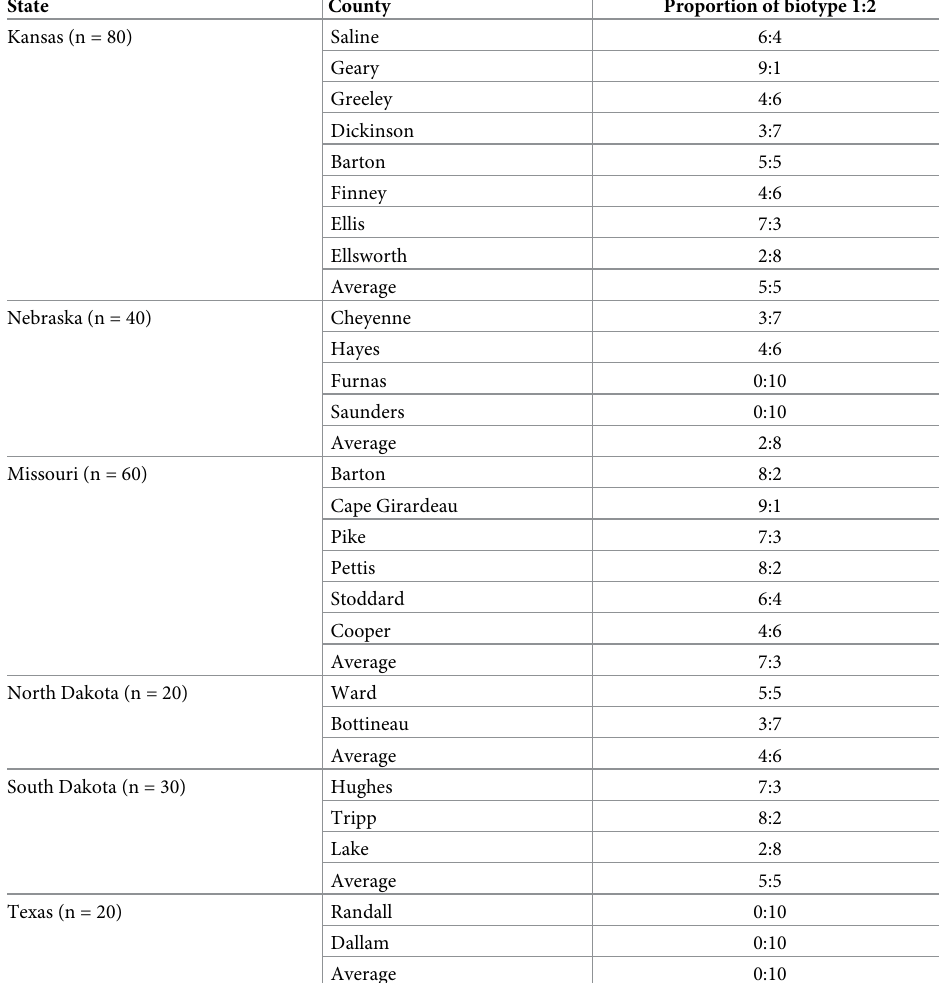
Table 1. Proportion of A . tosichella biotype 1 and 2 in samples collected in Kansas, Missouri, Nebraska, North Dakota, South Dakota and Texas in 2014 and 2015 (n = 10 per county).